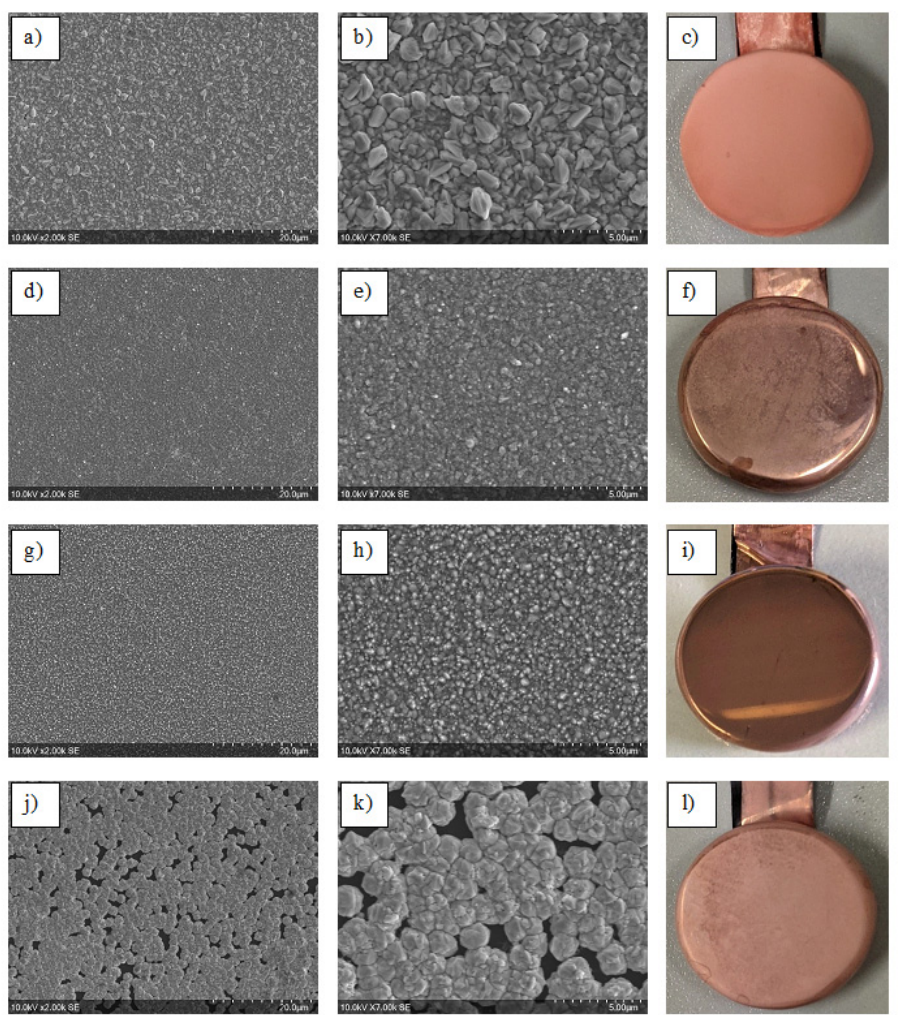
Figure 3. ( a , d , g , j ) SEM characterisation 2k× magnification; ( b , e , h , k ) 7k× magnification) and ( c , f , I , l ) sample photographs of the copper film obtained with various amount of TU: 1—0; 2—30; —60; 4— 90 ppm. Electrodeposition parameters: 600 s, –0.20 V, 25 °C. 3—60; 4—90 ppm. Electrodeposition parameters: 600 s, − 0.20 V, 25 ◦